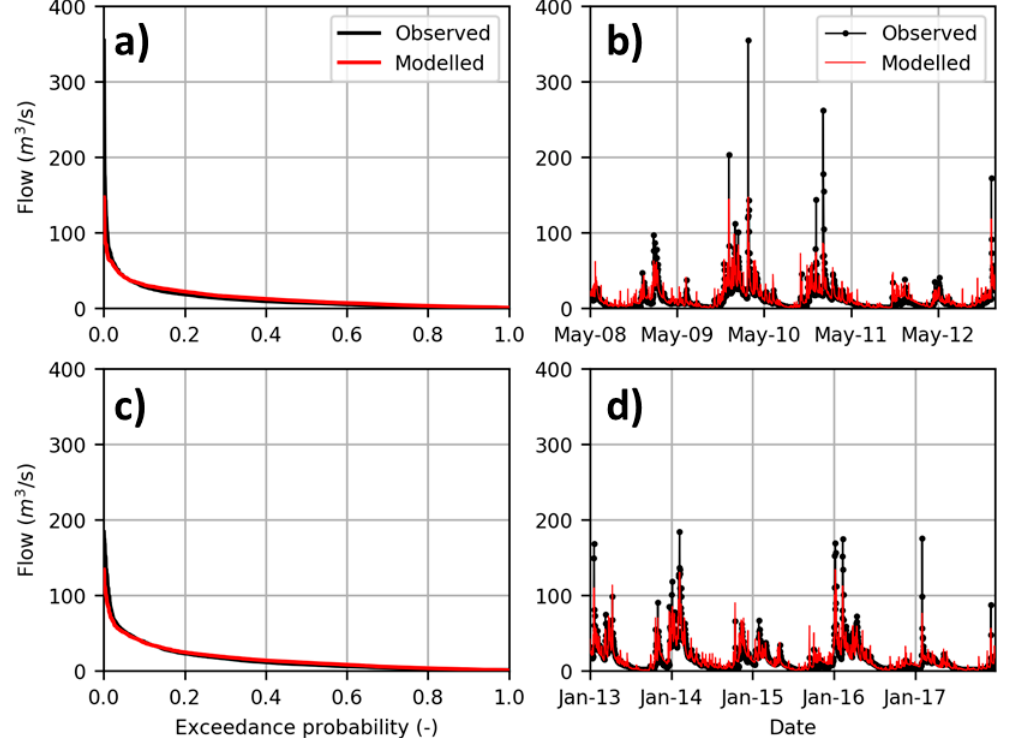
Figure 9. Comparison between modeled and observed flow values for calibration ( a , b ) and validation ( c , d ) periods in the Deza station. Table 7. Statistical parameters obtained during model calibration/validation at the Sar, Ulla, and Arnego-Ulla, and Deza hydrometric stations.